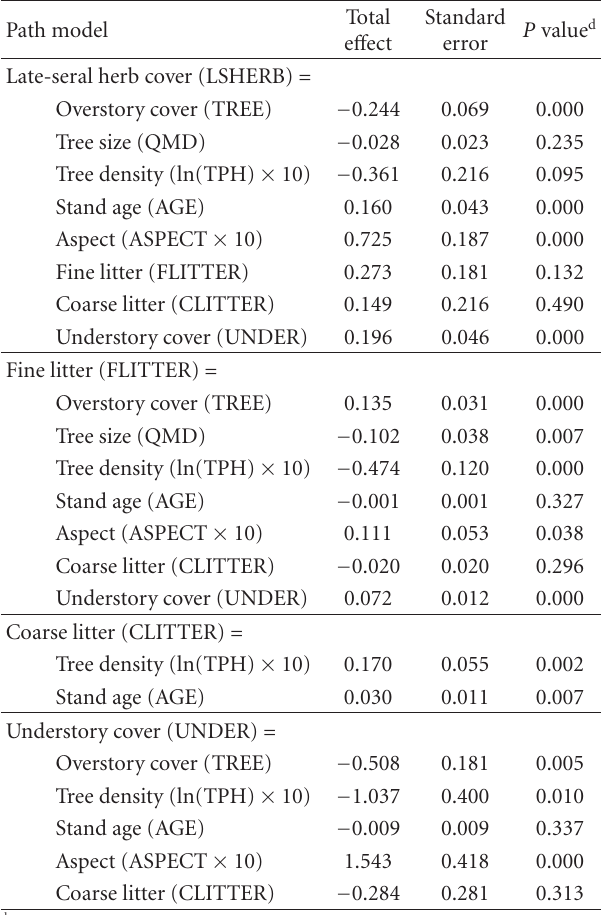
Table 5: Estimated total e ff ects (i.e., direct path and all possible indirect paths) on the endogenous latent variables in the overstory- understory SR model, along with corresponding standard errors and P